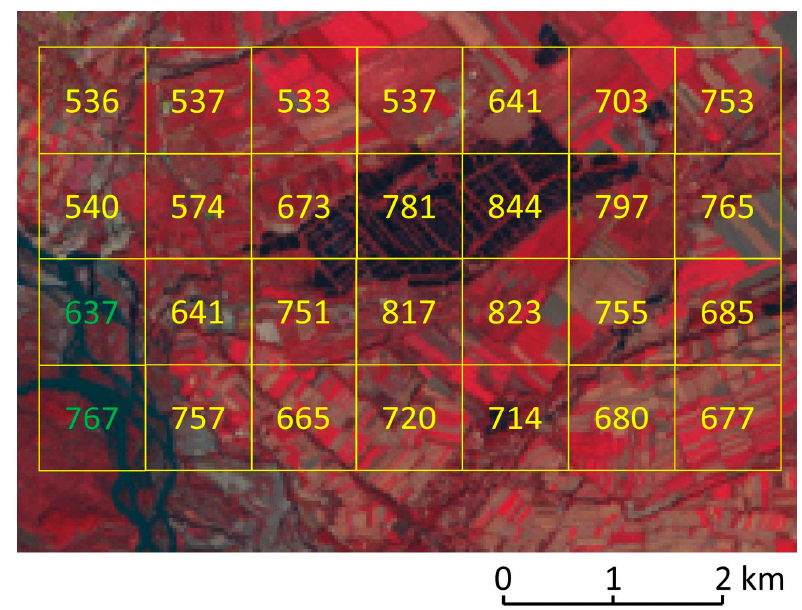
Figure 5. ET a of a representative area of agricultural land in the Ili Prefecture over the growing season of 2014. Yellow boxes show pixels of the ET a map. Yellow numbers: ET a (mm) within the given pixel. These pixels belong to agricultural land as used in this study. Green numbers: ET a (mm) within the given pixel. These pixels belong to riparian vegetation. Background: Landsat image (LC8, path 147, row 30) from 9 September 2013.